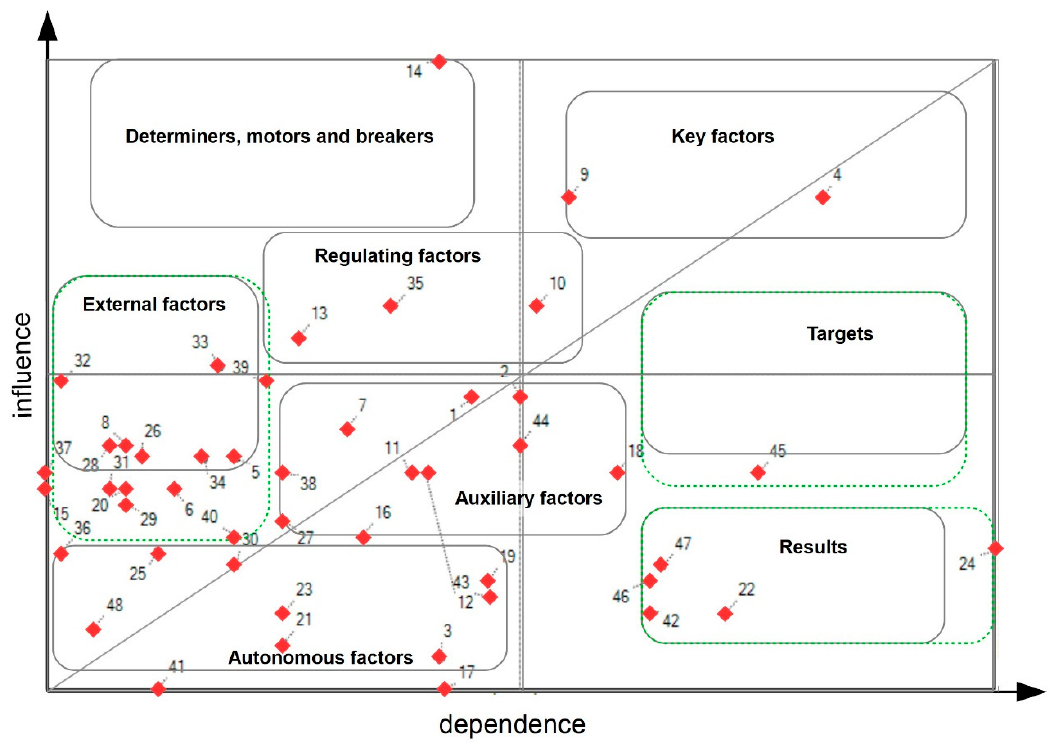
Figure 5. Diagram of direct influences, the numbers in the graph correspond to the variables’ numbers in Table 1.